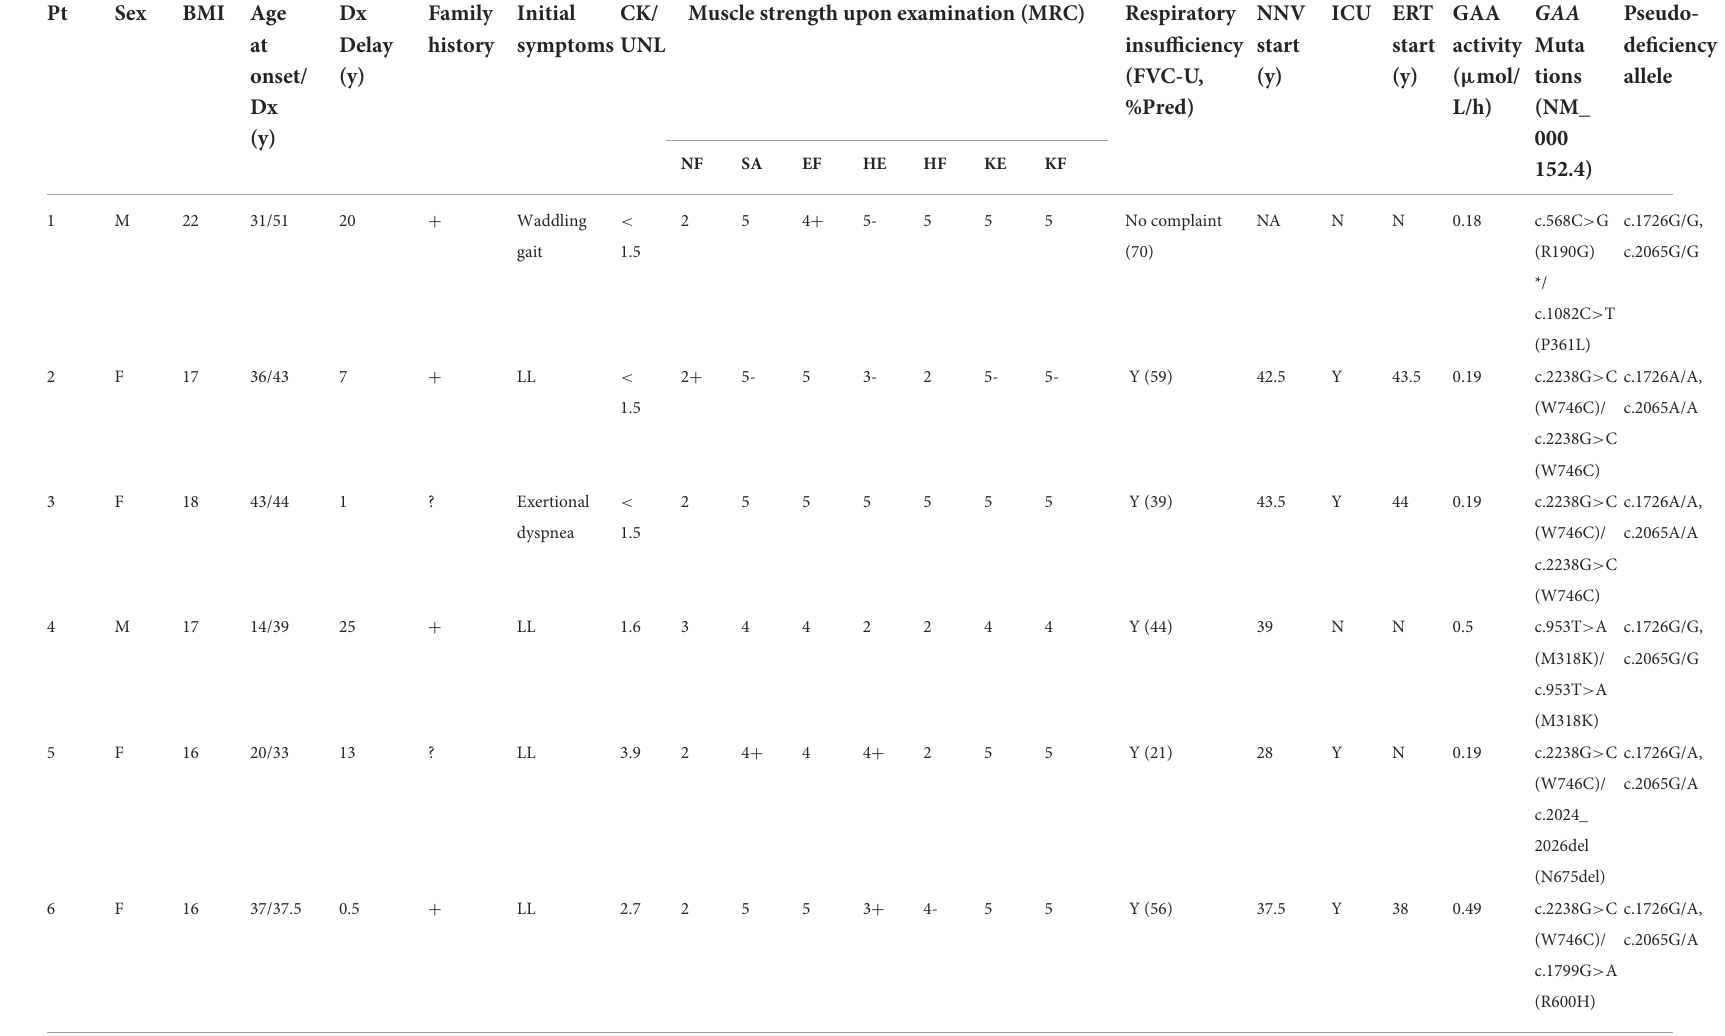
TABLE 2 The clinical characteristics and molecular analysis of eight newly diagnosed patients with